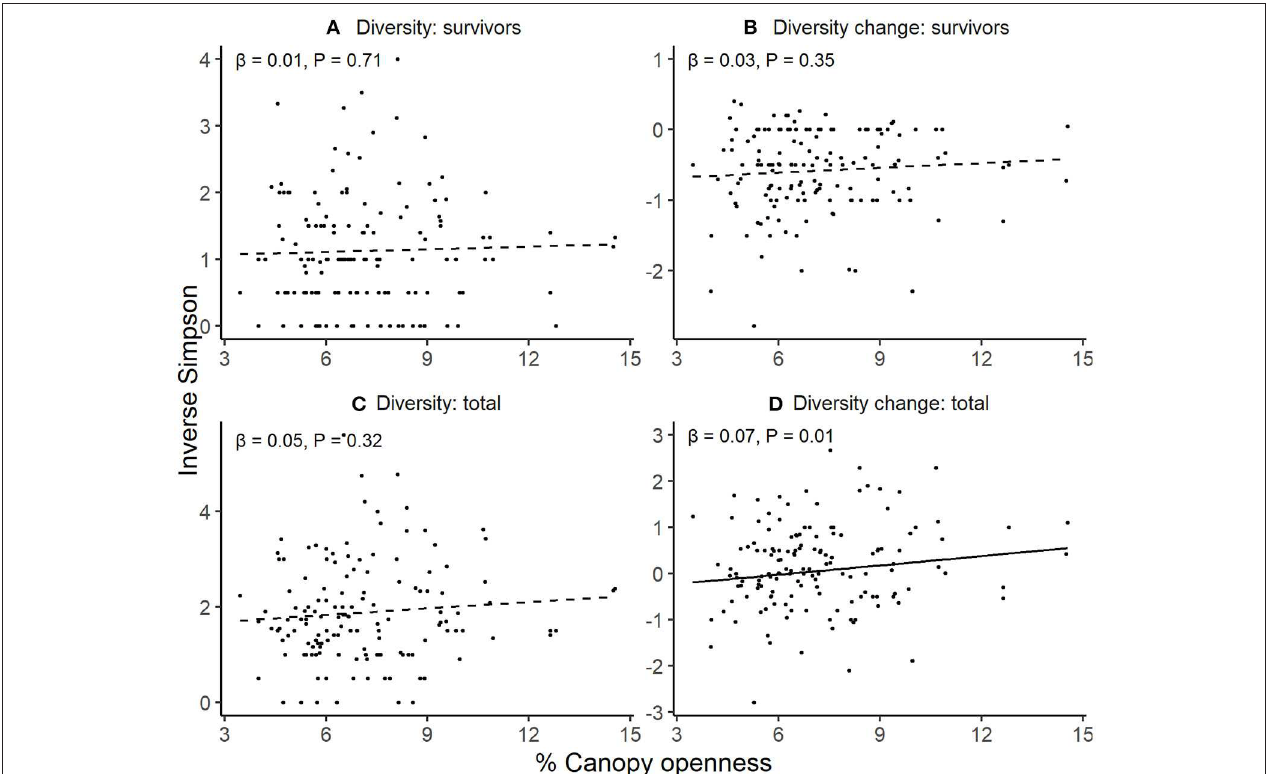
FIGURE 2 | Variation in seedling diversity with canopy openness. Through an annual recruitment cycle, in relation to increasing canopy openness across sites, (A) diversity of established seedlings alive at the end of the experiment, (B) change in diversity between initial seedling cohort and final survivors, (C) total seedling diversity including both recruits and survivors, and (D) change in diversity between initial seedling cohort and final seedling cohort including recruits. For each response, patterns were assessed using linear mixed effects models with station as a random intercept. Lines denote predicted responses from models; solid lines are significant and dashed lines are non-significant relationships estimated at alpha = 0.05.